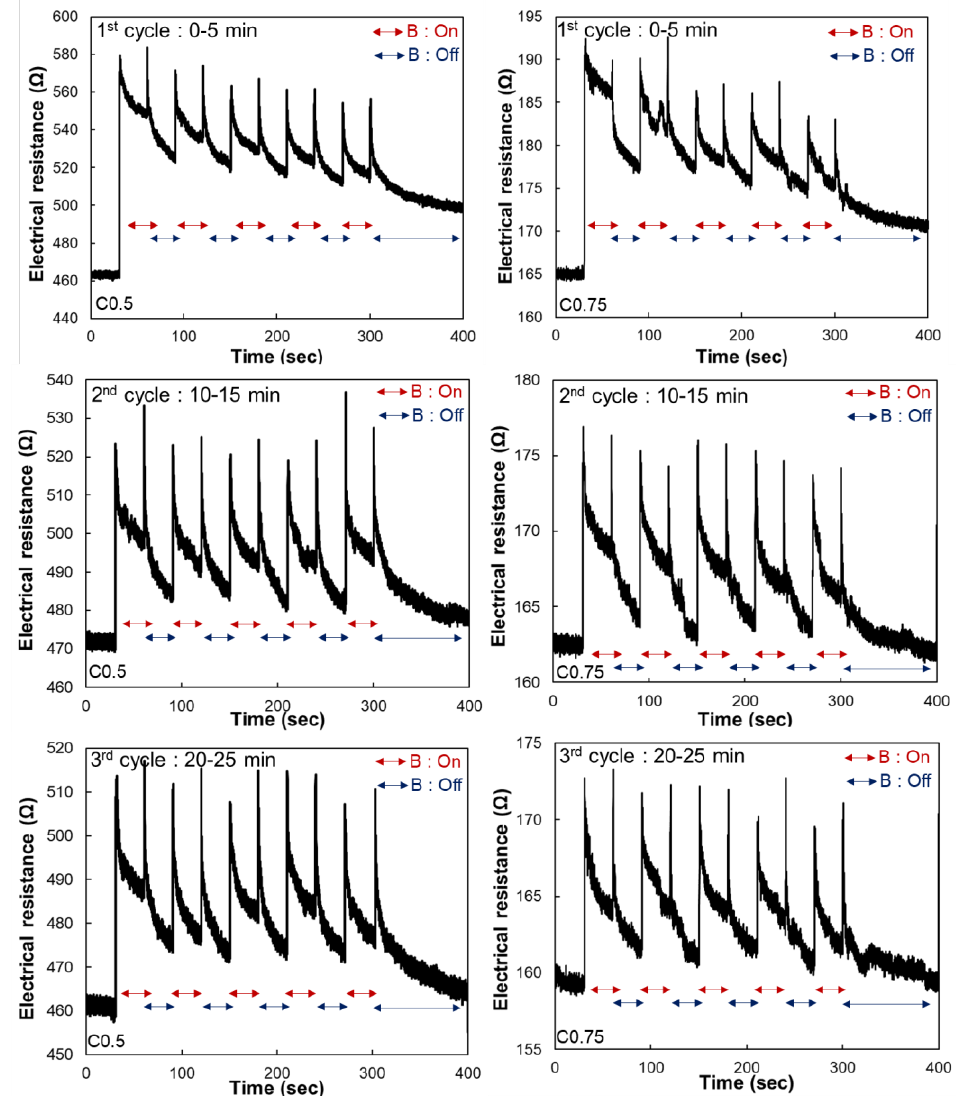
Figure 5. Magneto-resistances of the C0.5 and C0.75 samples under different levels of magnetic field.